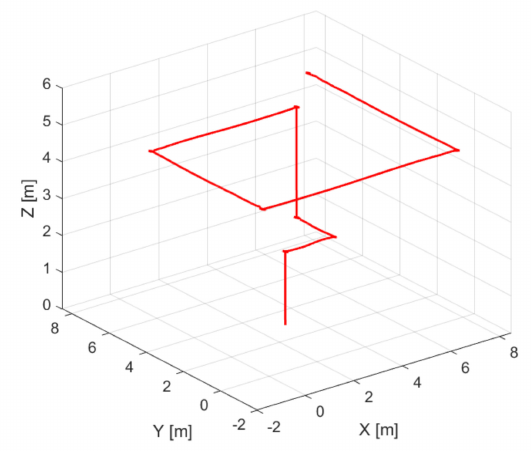
Figure 6. Quadrotor tracking system from initial position to target